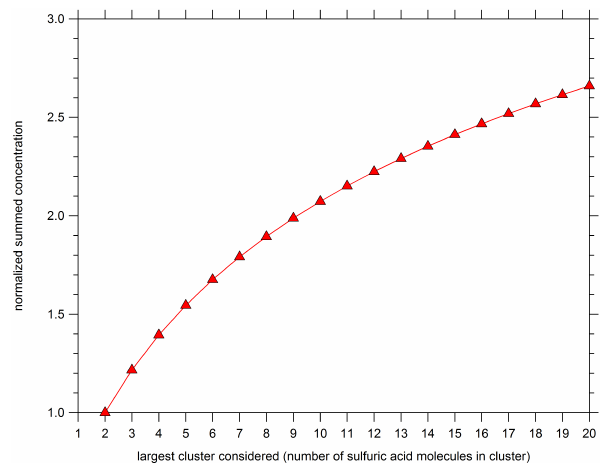
Figure 4. Sulfuric acid dimer concentration as a function of the monomer concentration at 208K for binary conditions. The full cir- cles are from neutral experiments obtained at steady state and the open triangles from ion-induced experiments. The black lines indi- cate the modeled dimer concentration for a given dimer evaporation rate with all other cluster evaporation rates set to zero. The color code indicates the relative humidity over supercooled